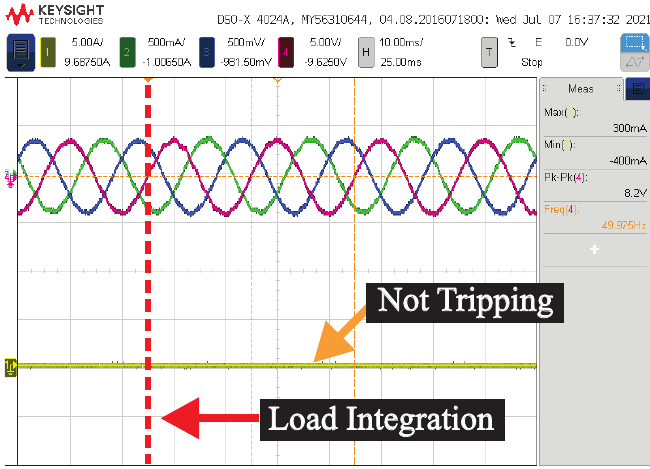
Figure 13. Large load integration tripping experimental results.